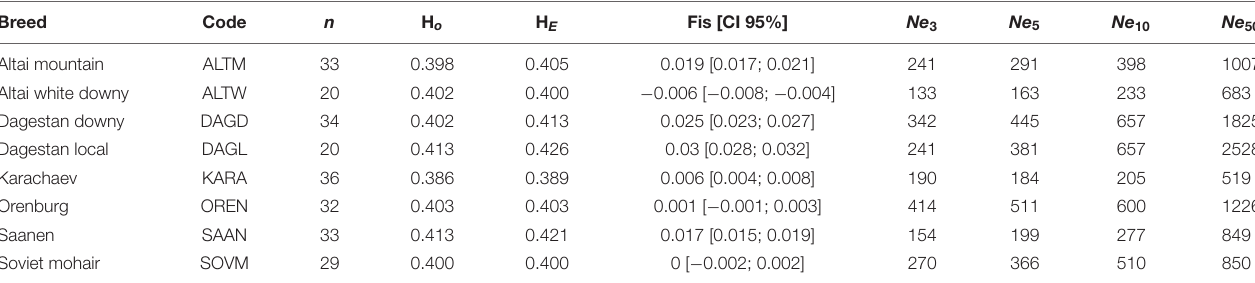
TABLE 2 | Diversity parameters and effective population sizes in Russian goat populations. Breed